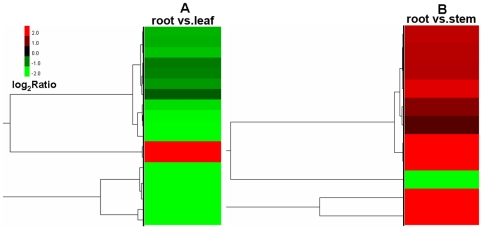
Gene ontology functional enrichment analysis for DEGs.A, the statistically significant term from the molecular function ontology is structural molecule activity in the comparison of the root and the leaf; the cluster image of expression patterns of DEGs under this term is shown. B, the statistically significant term from the cellular component ontology is photosynthetic membrane in the comparison of the root and the stem; the cluster image of expression patterns of DEGs under this term is shown. Each row represents a gene. Expression differences are shown in different colors. Red means up-regulated and green means down-regulated.